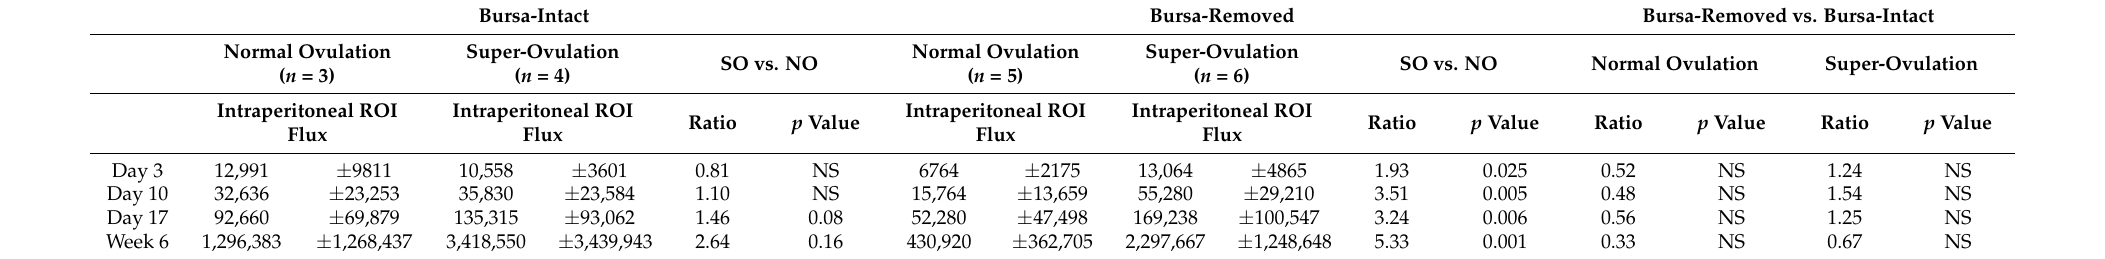
Table 1. Intraperitoneal tumor signal detected by IVIS at different time points in different mouse groups. Bursa-Intact Bursa-Removed Bursa-Removed vs.